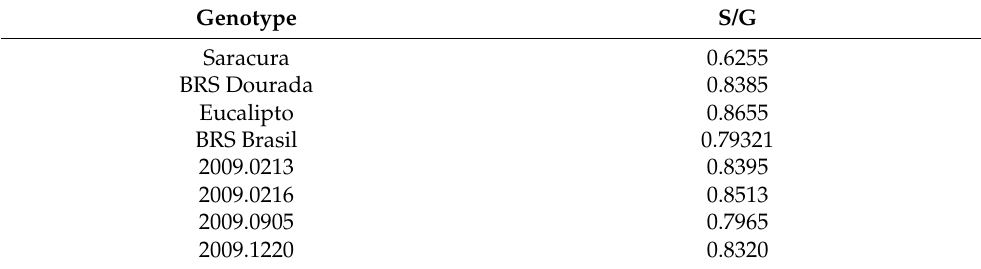
Table 3. Ratio of syringyl/guaiacyl (S/G) from the different cassava